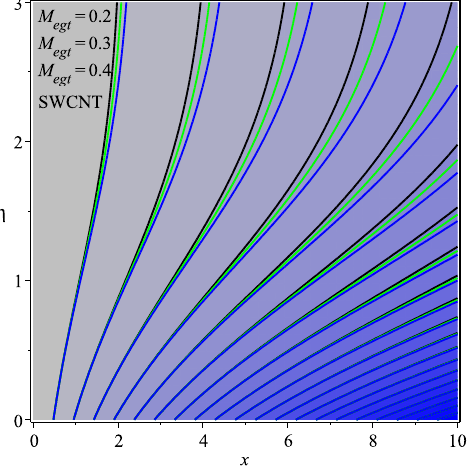
Figure 21. Repercussion of M egt with φ = 0.1, ω = π /3, Ω = 1, κ = 2.5 on stream lines.